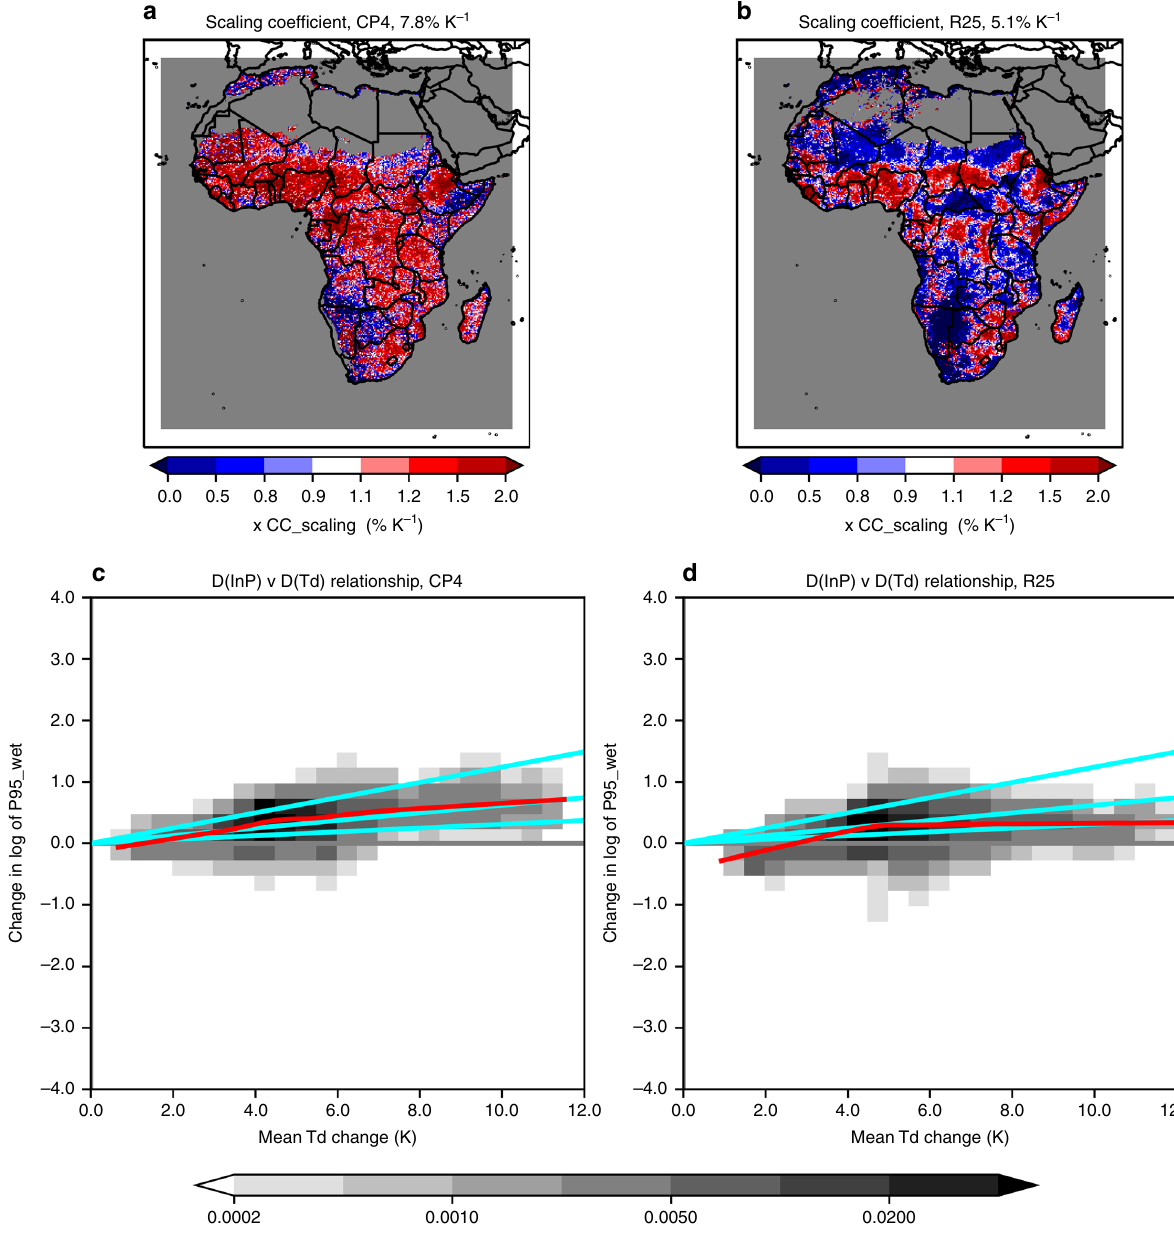
Fig. 10 Scaling between future changes in extreme 3-hourly precipitation intensity and the dew point temperature. a , b Scaling coef fi cient given by future change in logarithm of extreme precipitation intensity divided by future change in mean dew point temperature, for the wet season, for CP4A and R25. The median scaling across Africa is indicated in the panel titles; colours correspond with the scaling coef fi cient divided by the Clausius – Clapeyron relationship of 6.2%K − 1 (such that a value of 1 corresponds to CC scaling). c , d Joint probability distribution of change in logarithm of extreme precipitation intensity versus change in mean dew point temperature T d , for the wet season, across Africa, for CP4A and R25. Cyan lines show the relationship for 0.5, 1 and 2 times CC-scaling; red lines show the average relationship obtained from fi tting a Lowess regression line. Extreme precipitation intensity is de fi ned as the 95th percentile of wet values (>0.1 mm h − 1 ), for daily maximum 3-hourly precipitation, and is set to missing (and masked in grey) over sea points and where less than 5% of the data is wet. The wet season is the 3-month period with the highest mean precipitation in TRMM, de fi ned on a grid-point